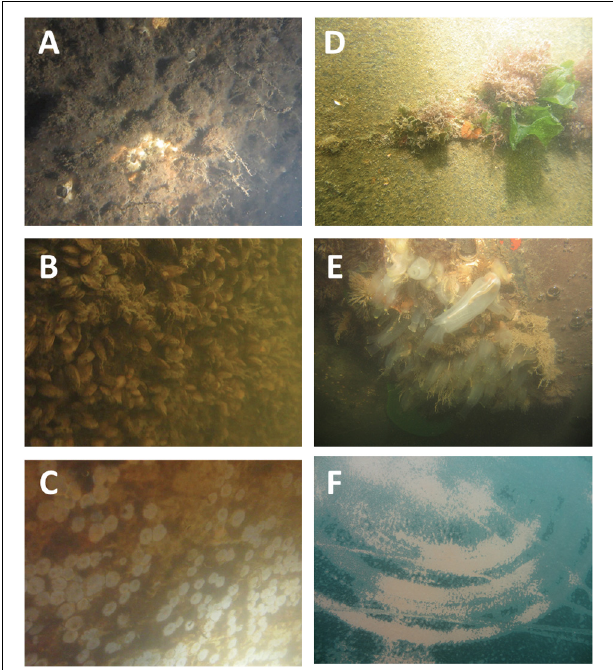
FIGURE 4 | Examples of biofouling cover for Vessel 1 (A–C) and Vessel 2 (D-F). Biofouling on Vessel 1 consisted of dense cover of barnacles, hydroids, mussels, and bryozoans (A,B) , which was subsequently removed in the treated area during cleaning to leave barnacle scars and residual organisms, mainly bryozoans (C) . Biofouling on Vessel 2 comprised thick biofilms and clusters of macro-organisms (D,E) which were removed to a large extent during cleaning (F)